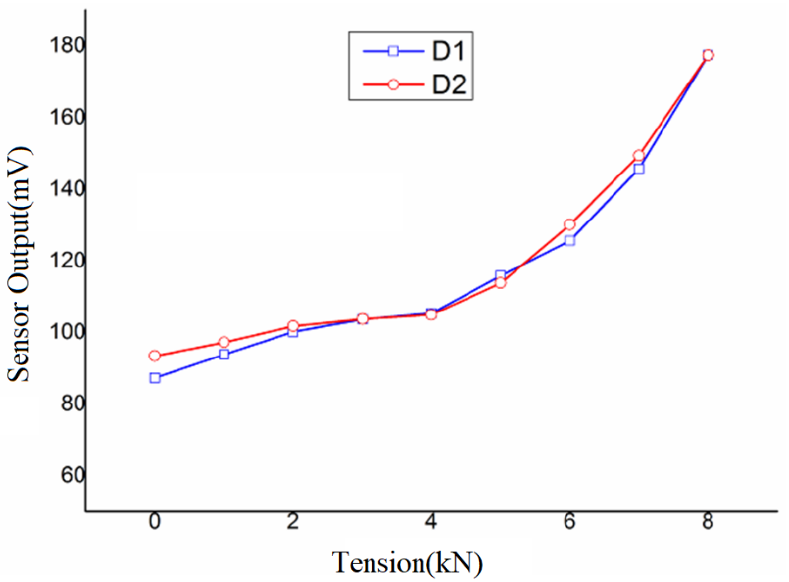
Figure 12. Sense signal curve with gaps variation of the excitation sensor and the steel